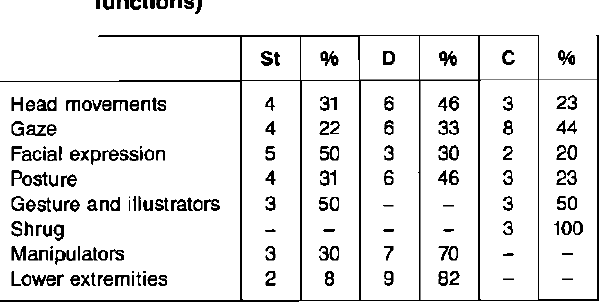
Table 9 Summary of the comparison of scores of nonver- bal stuttering (St) distracting (D) and complement- ing (C) behaviours (Percentages were calculated relative to the frequency of occurrence of the